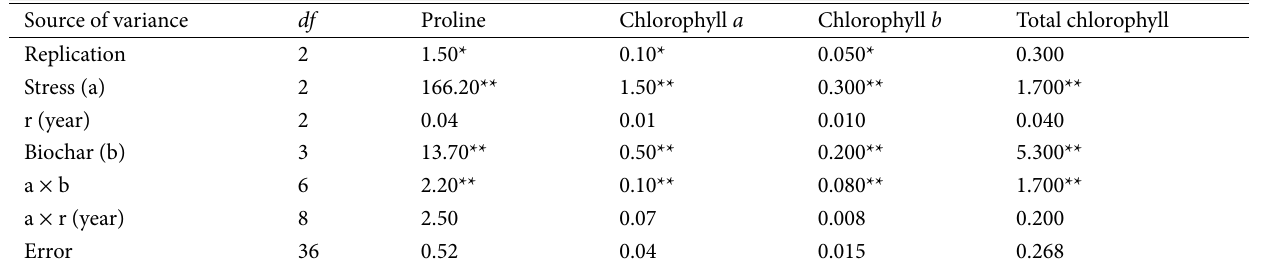
Table 4 Analysis of variance (ANOVA) for the effect of biochar on some properties of melon plants under drought stress. Source of variance df Proline Replication